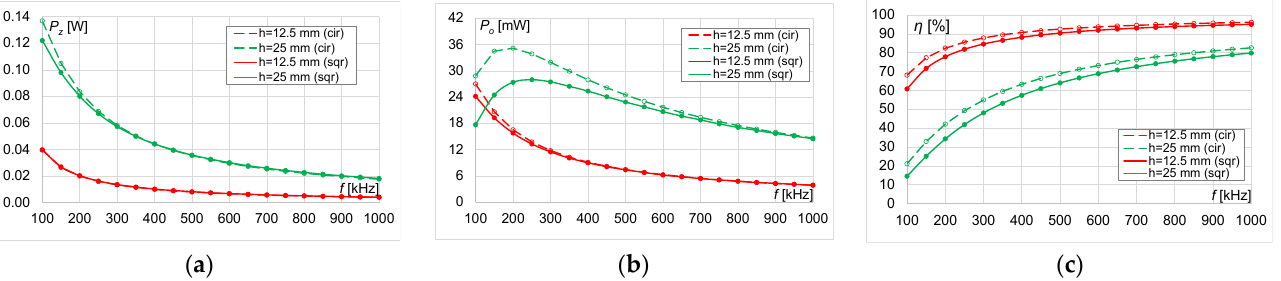
Figure 16. Results for circular and square coils with r = 25 mm and number of turns n = 80 at different distances ( h = 12.5 mm and h = 25 mm): ( a ) transmitter power, ( b ) receiver power and ( c ) power transfer efficiency.